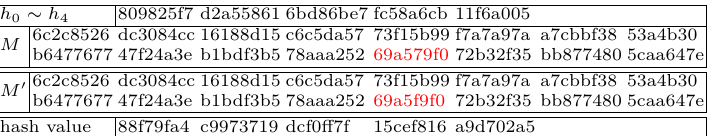
Table 5: SFS collision for 36 steps of RIPEMD-160